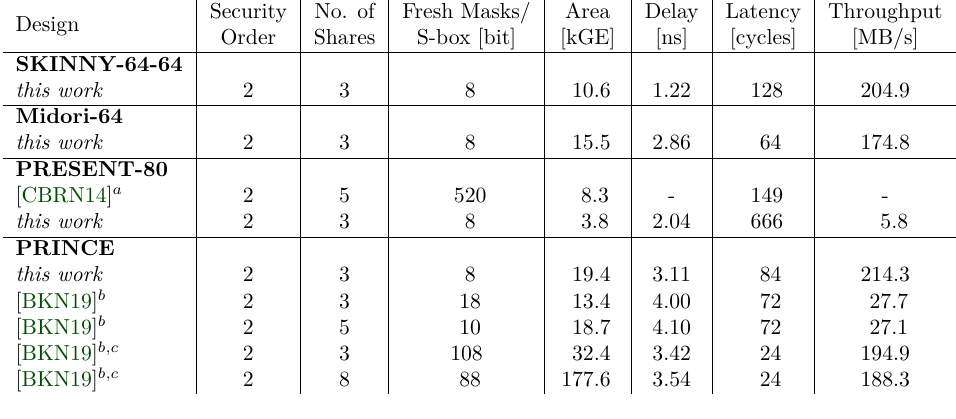
Table 2: Performance figures of different implementations, including key masking. (using Synopsis Design Compiler, and UMC 90 standard cell library, excluding PRNGs)